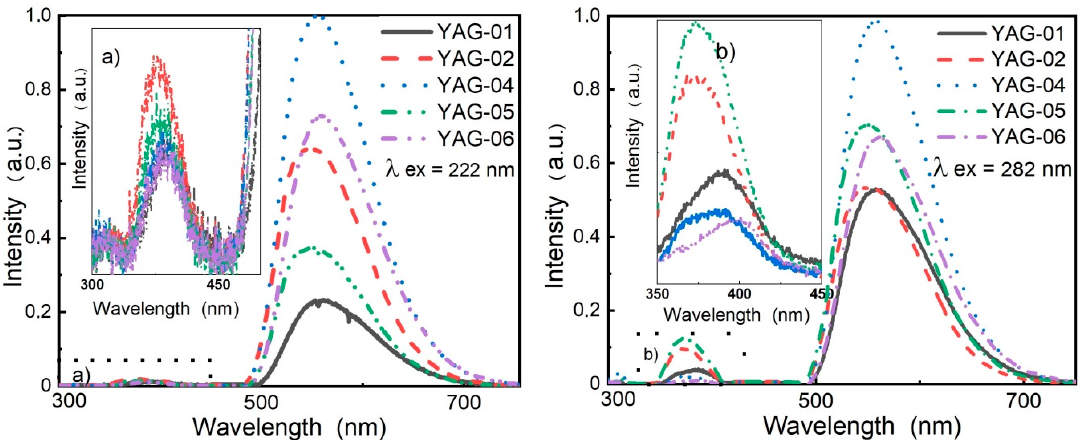
Figure 6. Luminescence spectra of C-YAG phosphors under excitation by radiation of KrCl ( λ = 222 nm) and XeBr ( λ = 282 nm) excilamps. The insets ( a , b ) provide enlarged luminescence spectra in the UV region.